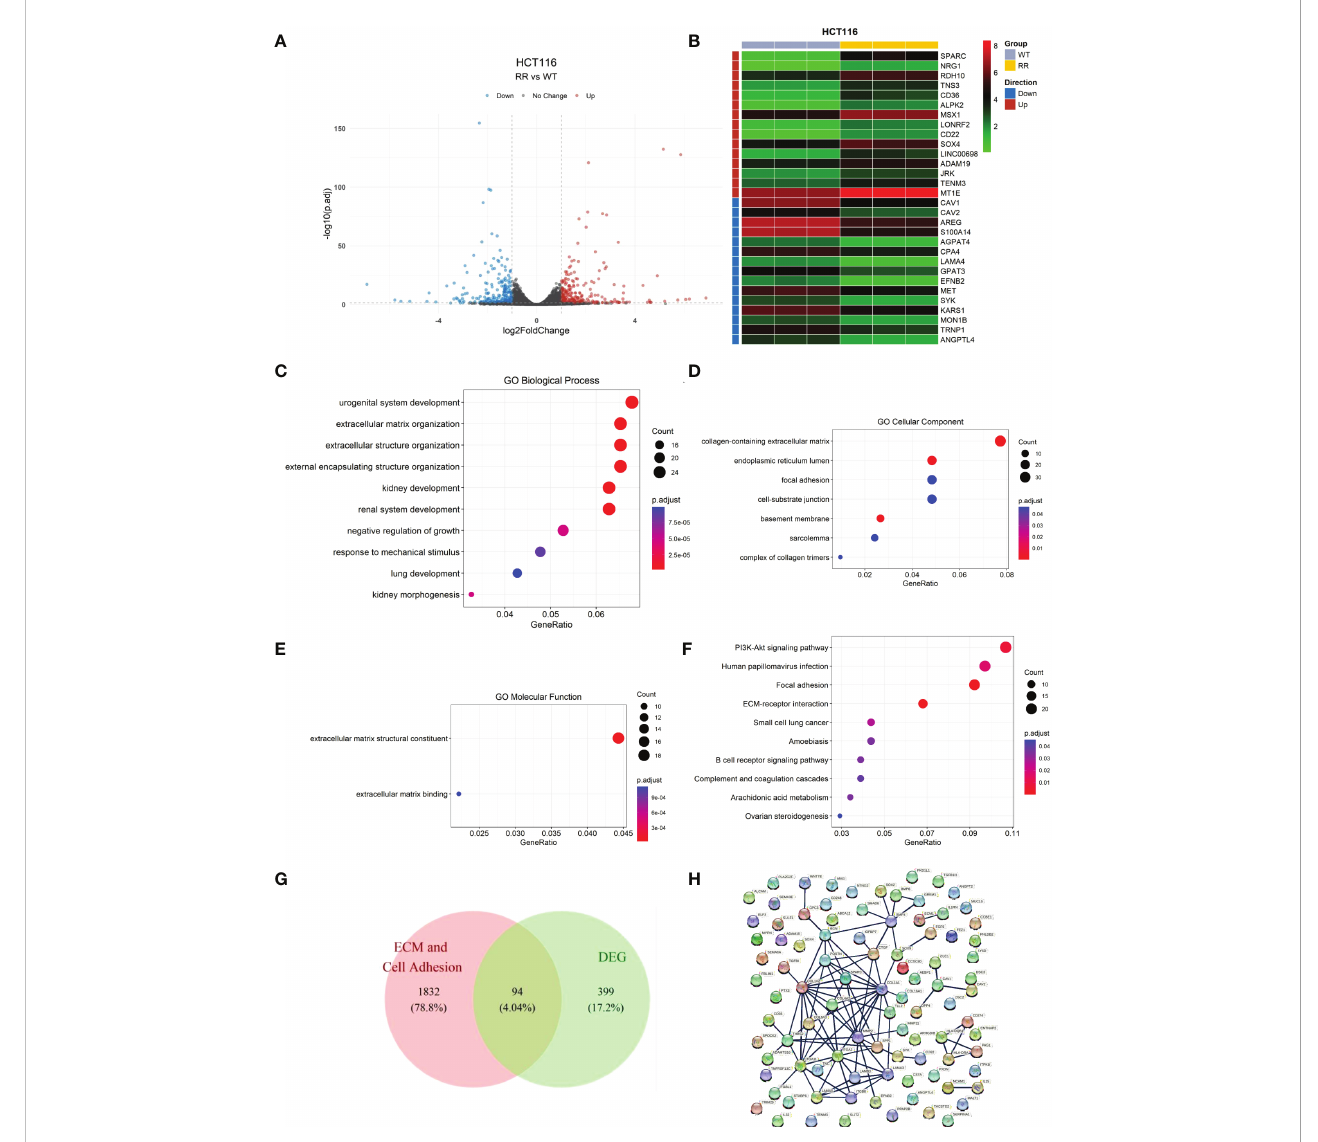
FIGURE 1 Identi fi cation of differentially expressed genes in radiotherapy-tolerant cell lines RR and WT compared to those in WT in HCT-116 cells. (A) Volcano plot of differential gene expression analysis. (B) Heat map of differentially expressed genes. (C) Differentially expressed gene enrichment results: GO biological processes. (D) Differentially expressed gene enrichment results: GO cellular components. (E) Differentially expressed gene enrichment results: GO molecular functions. (F) Differentially expressed gene KEGG enrichment results. (G) Candidate gene screening Wayne diagram. (H) Candidate gene protein interactions